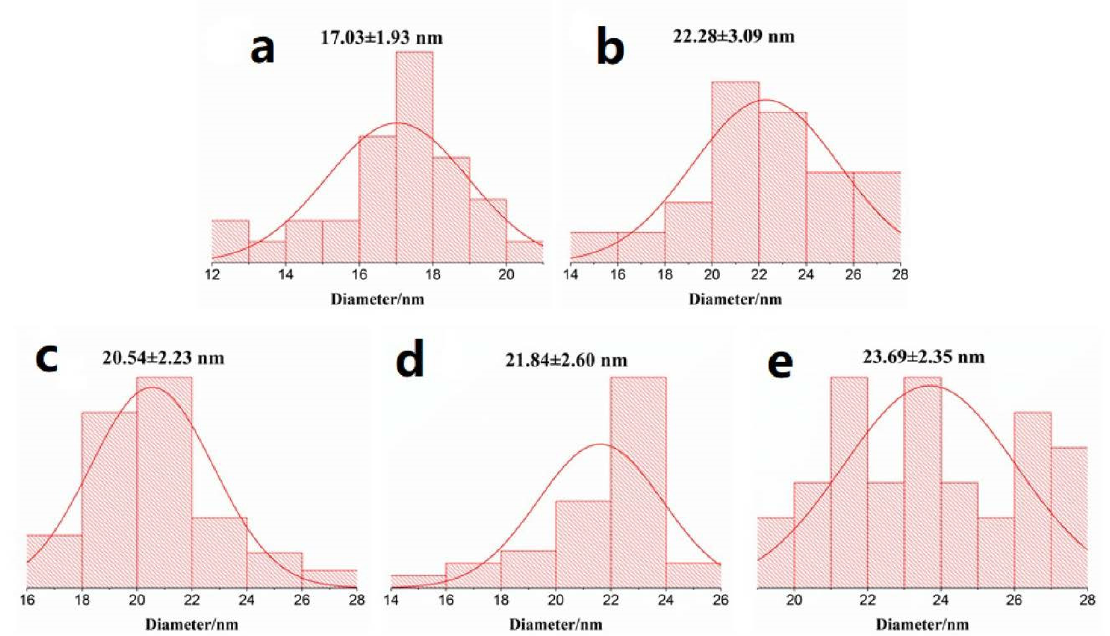
Figure 4. Particle size distribution of ( a ) PtNiCo/rGO 200, ( b ) PtNiCo 2 /rGO 200, ( c ) PtNiCo/rGO 160, ( d ) PtNiCo/rGO 180, ( e ) PtNiCo/rGO 220.